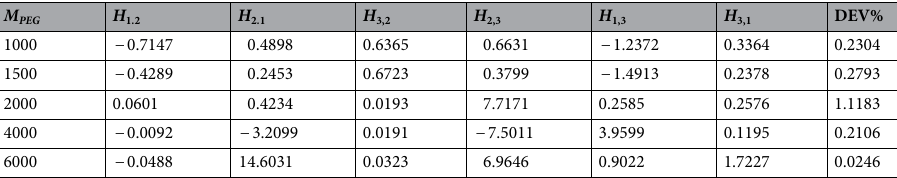
Table 8. Results of the modelling of the experimental tie-line compositions with e-Wilson model for PEG 1000,1500,2000,4000,6000 (1) + trilithium citrate (2) + water (3) system at T = 298.15